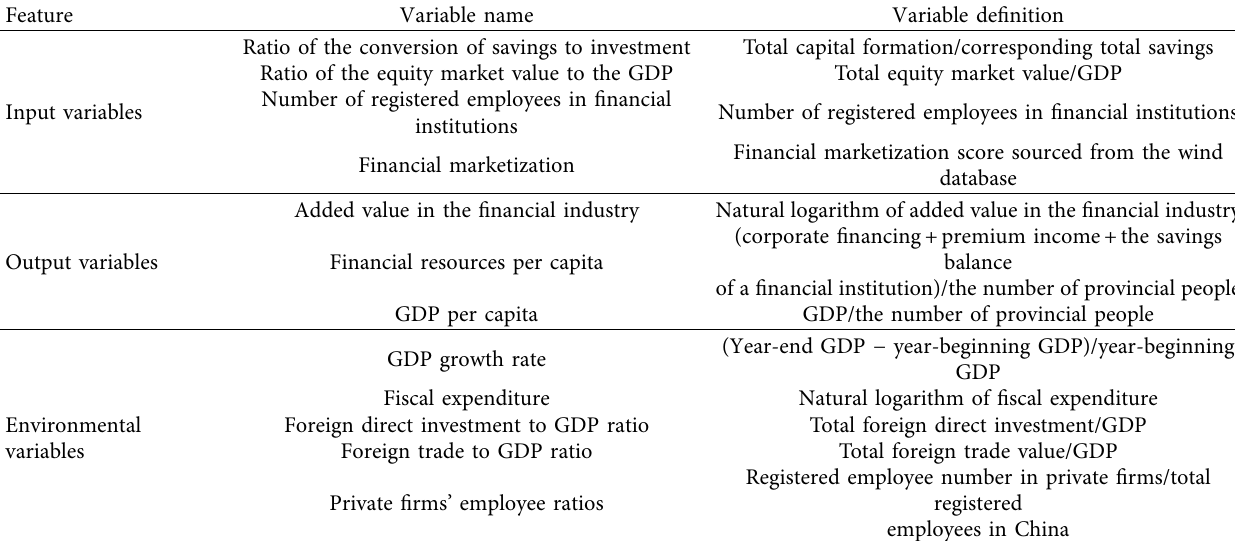
Table 2: Multiple inputs and outputs of the financial efficiency